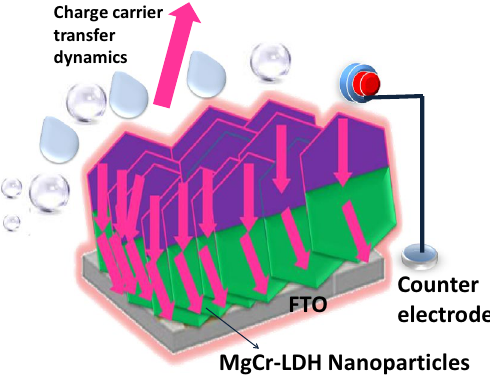
Figure 15. Schematic illustration of the future proposed expected carrier charge transfer dynamics of deposited MgCr-LDH/NP photocatalyst to current-collector